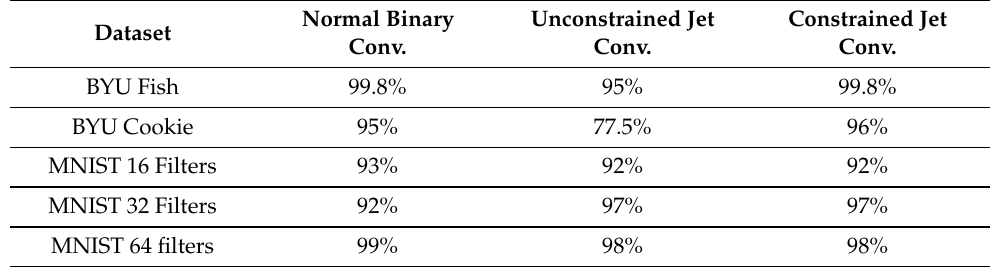
Table 2. Performance